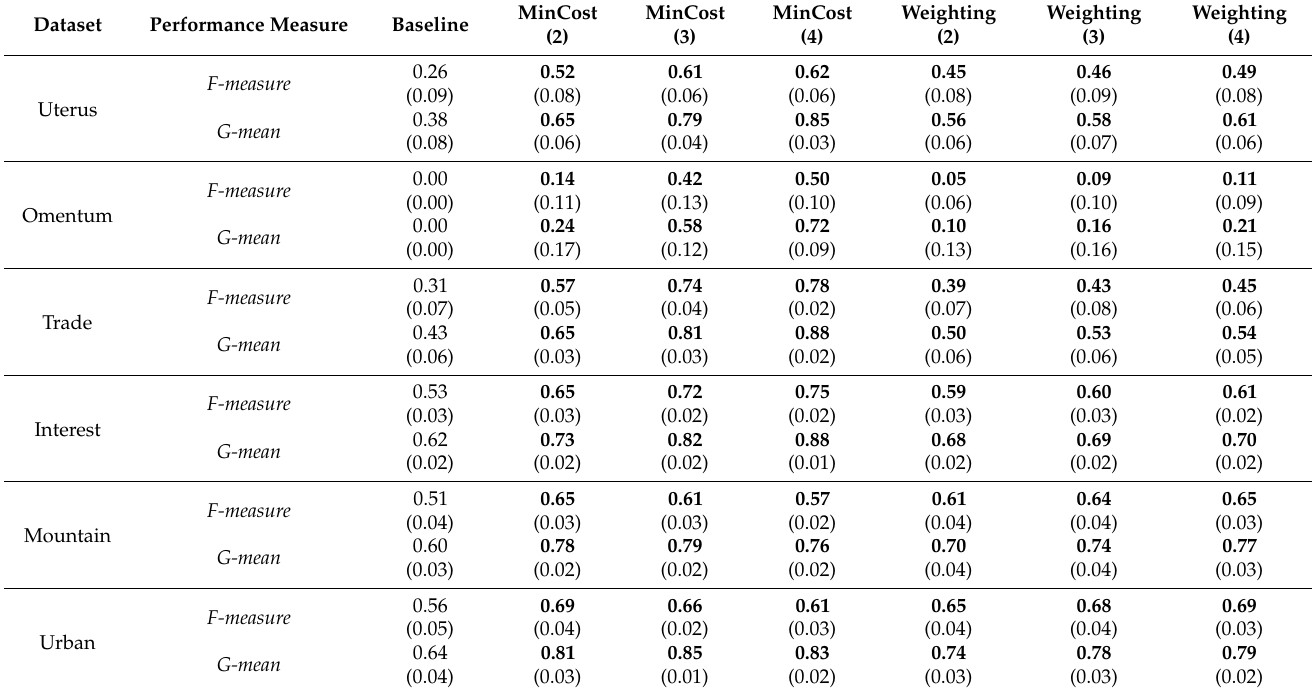
Table 4. F-measure and G-mean performance of the RF classifier, with and without cost-sensitive corrections.